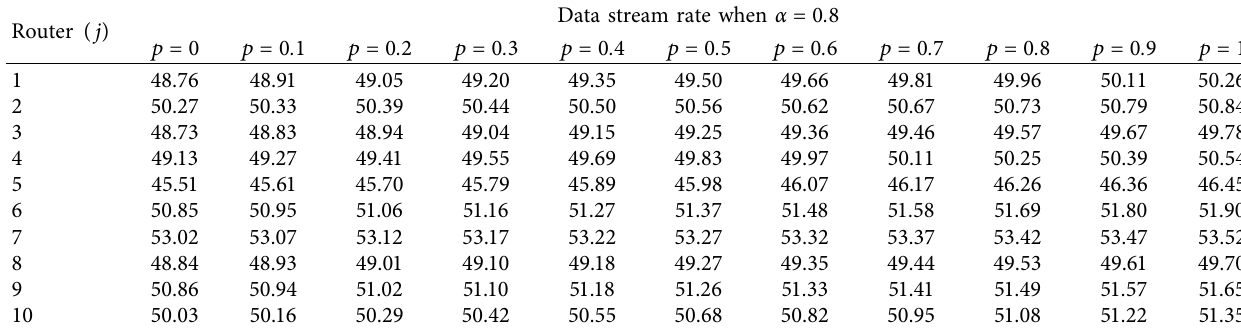
Table 8: Data stream rate for different values of p and α � 0 . 8.